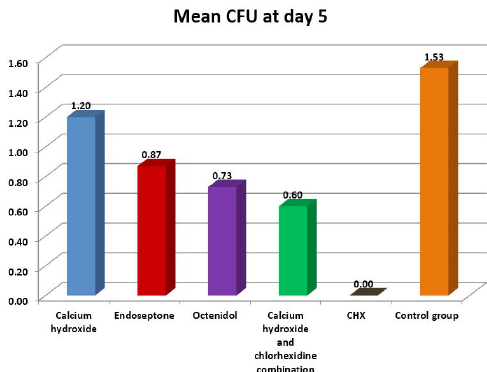
Table 10. Difference of CFU at day 5 between various medicaments